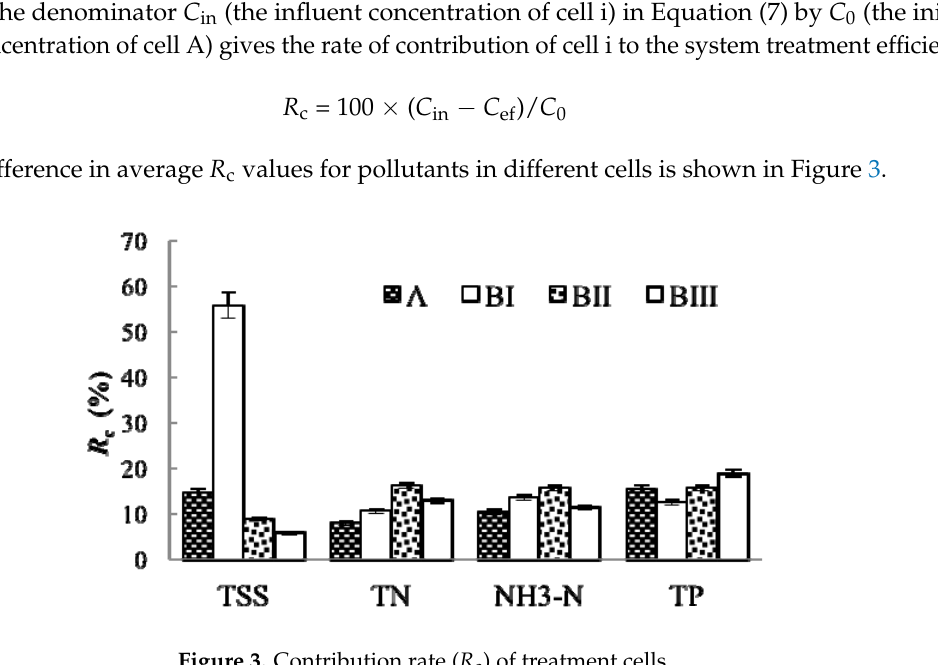
Figure 3. Contribution rate ( R c ) of treatment cells.